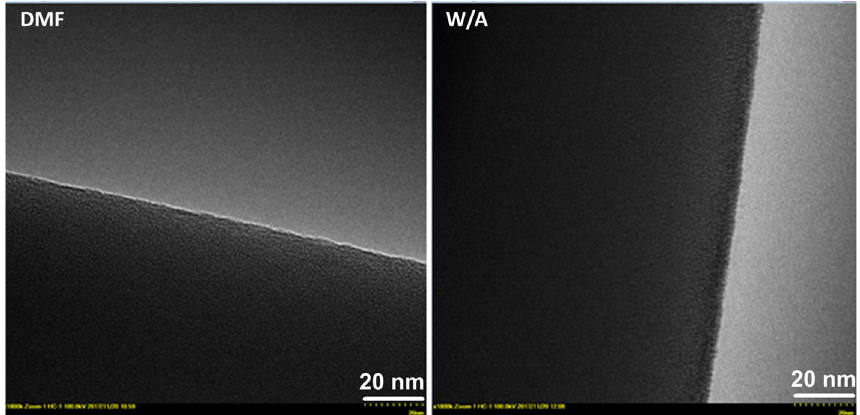
Figure 5. TEM micrographs at 1,800,000 × magnification showing electrospun fibers obtained in DMF and W/A at 160% ( w/v ).